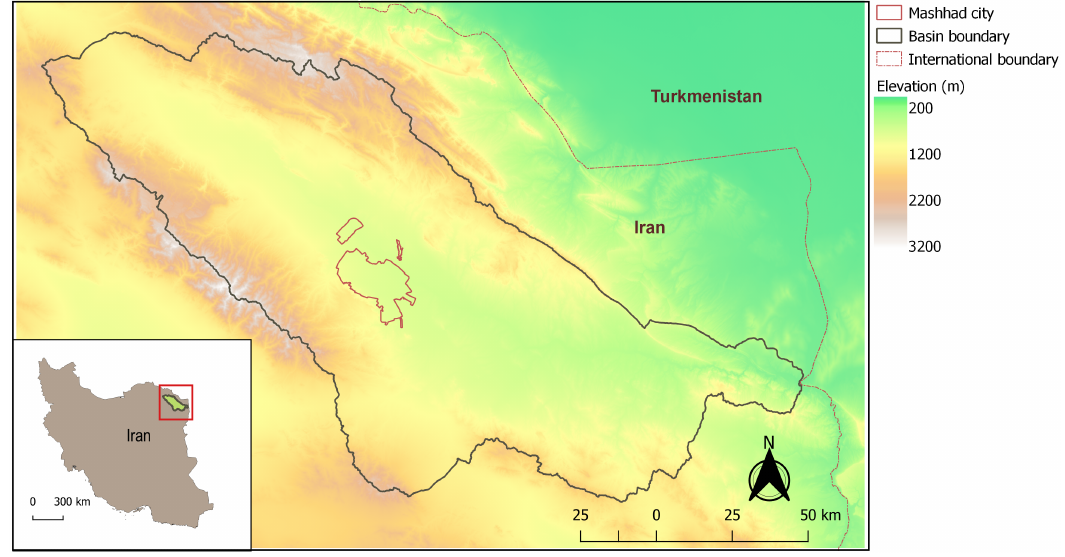
Figure 1. Study area: Mashhad basin in the northeast of